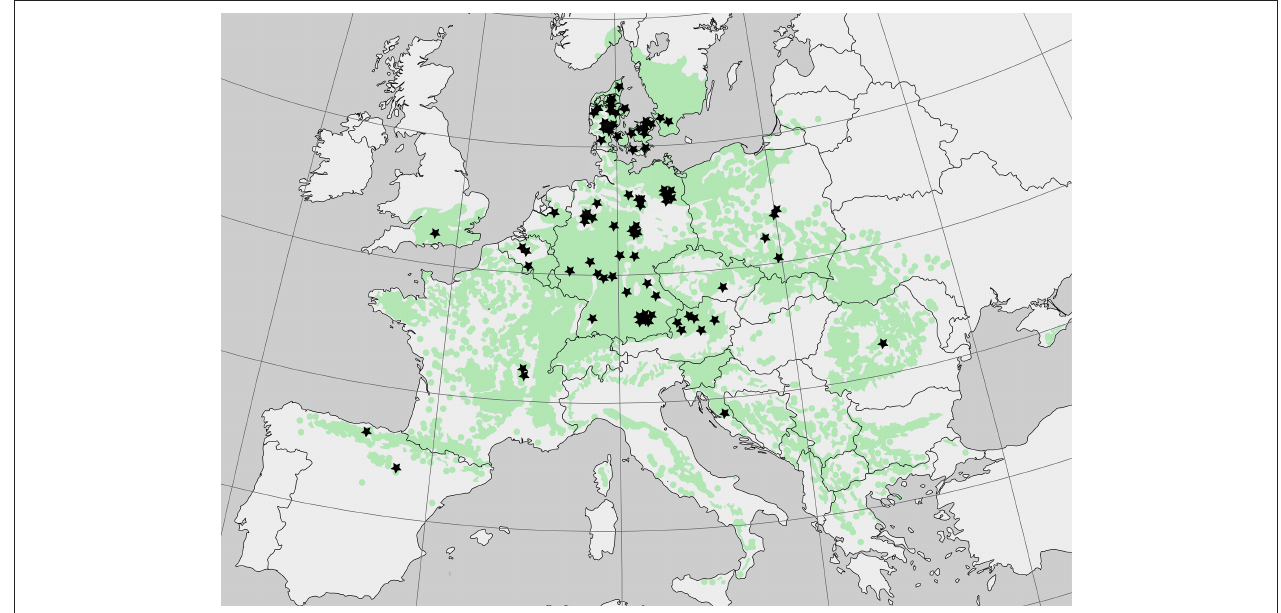
FIGURE 1 | Distribution of forest sites included in the meta-analysis ( n = 102) illustrated by stars. The green color indicates the potential natural distribution area of European beech. Source: http://www.euforgen.org/species/fagus-sylvatica/.